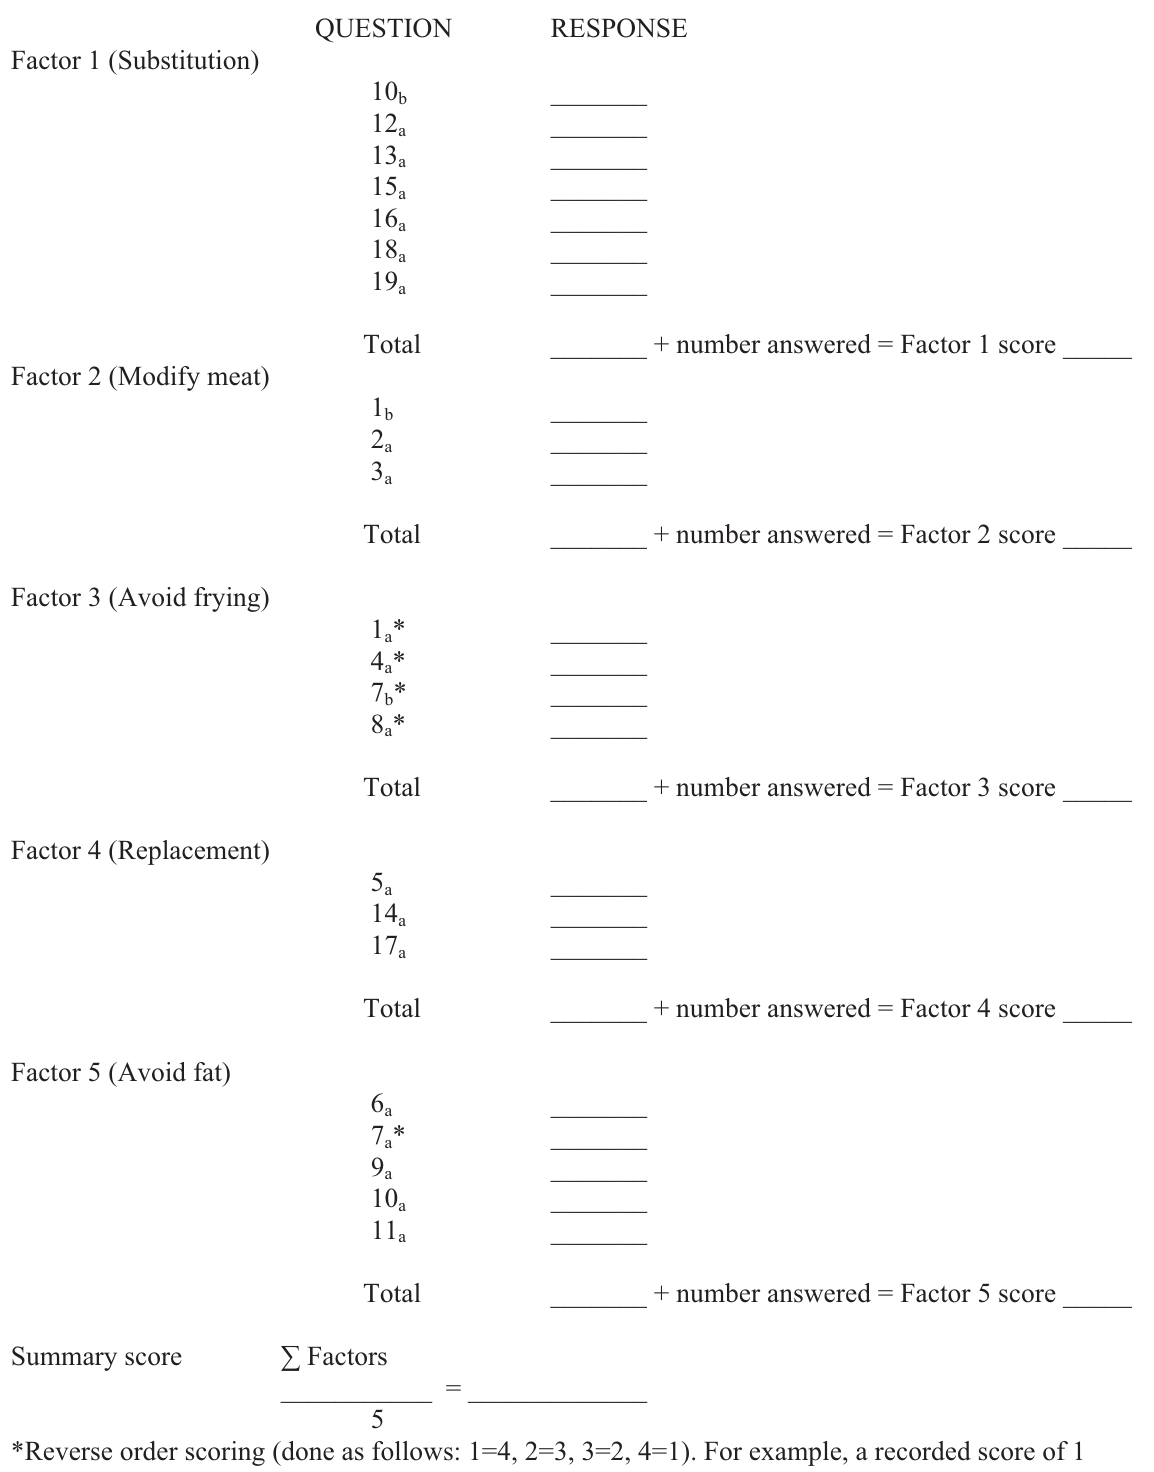
Fat-Related Diet Habits Questionnaire Eating Pattern Score